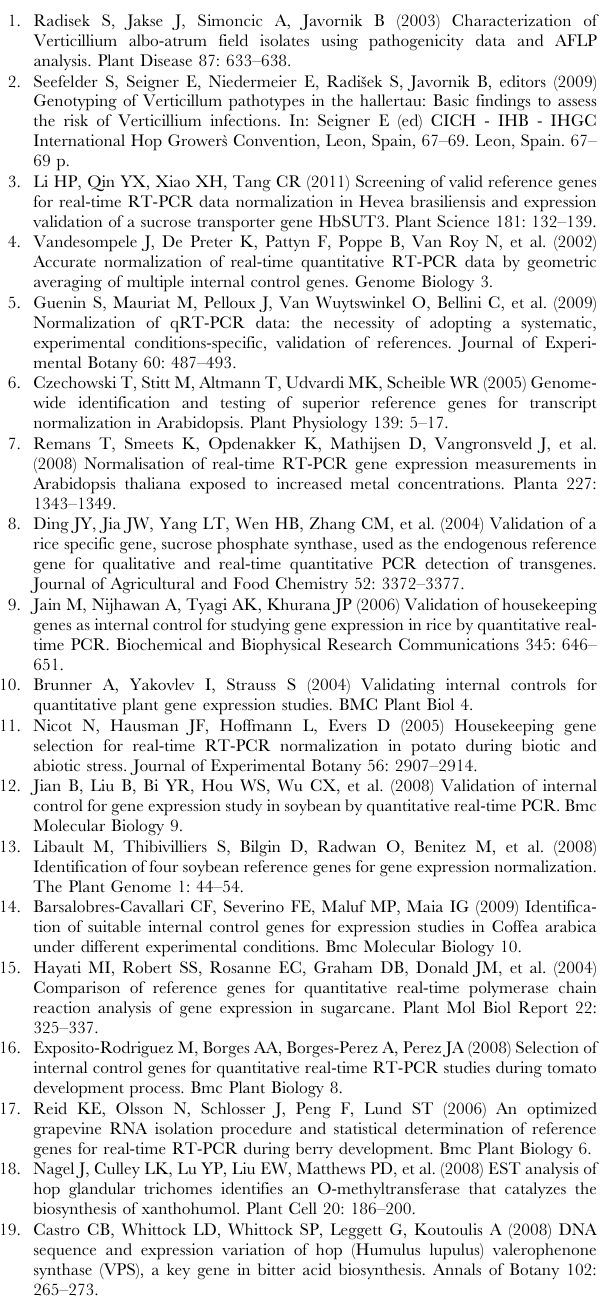
points (10, 20, 30 dpi). Expression values were normalized with three normalization factors obtained from two best reference genes (YLS8/DRH1), 14 best reference genes and least stable gene ( NADH ) and were compared to non-normalized (raw) values. s e represent standard errors. Different letters indicate statistical significance based on Tukey’s multiple comparisons test of individual averages of expression